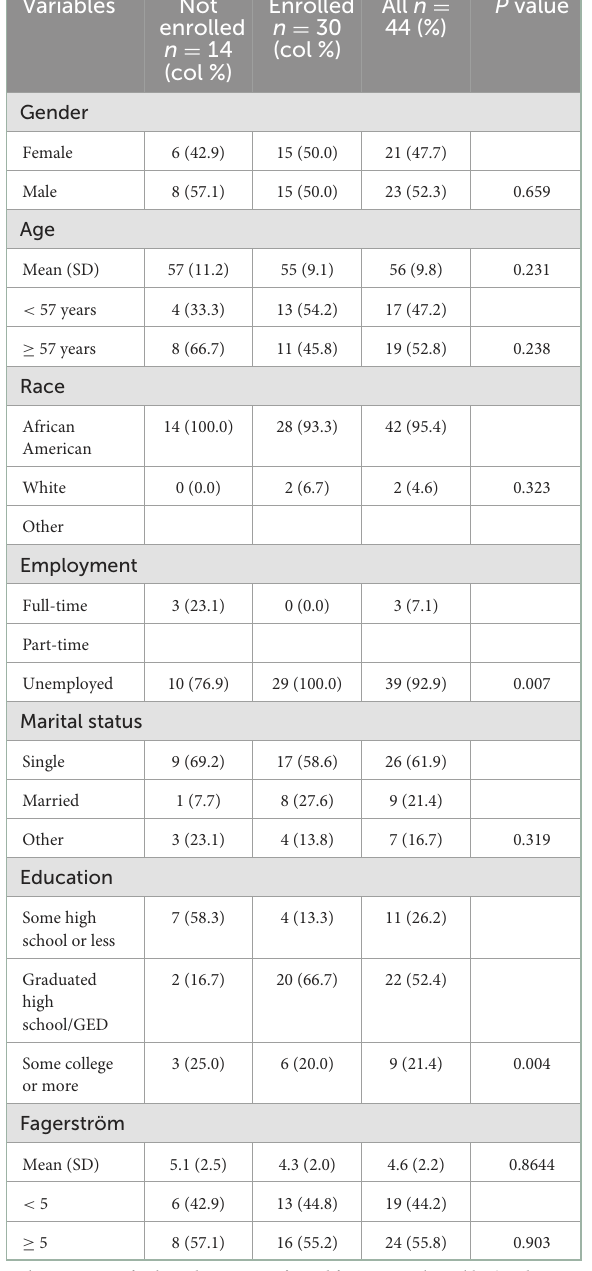
TABLE 1 Sociodemographic and baseline characteristics of public housing participants.